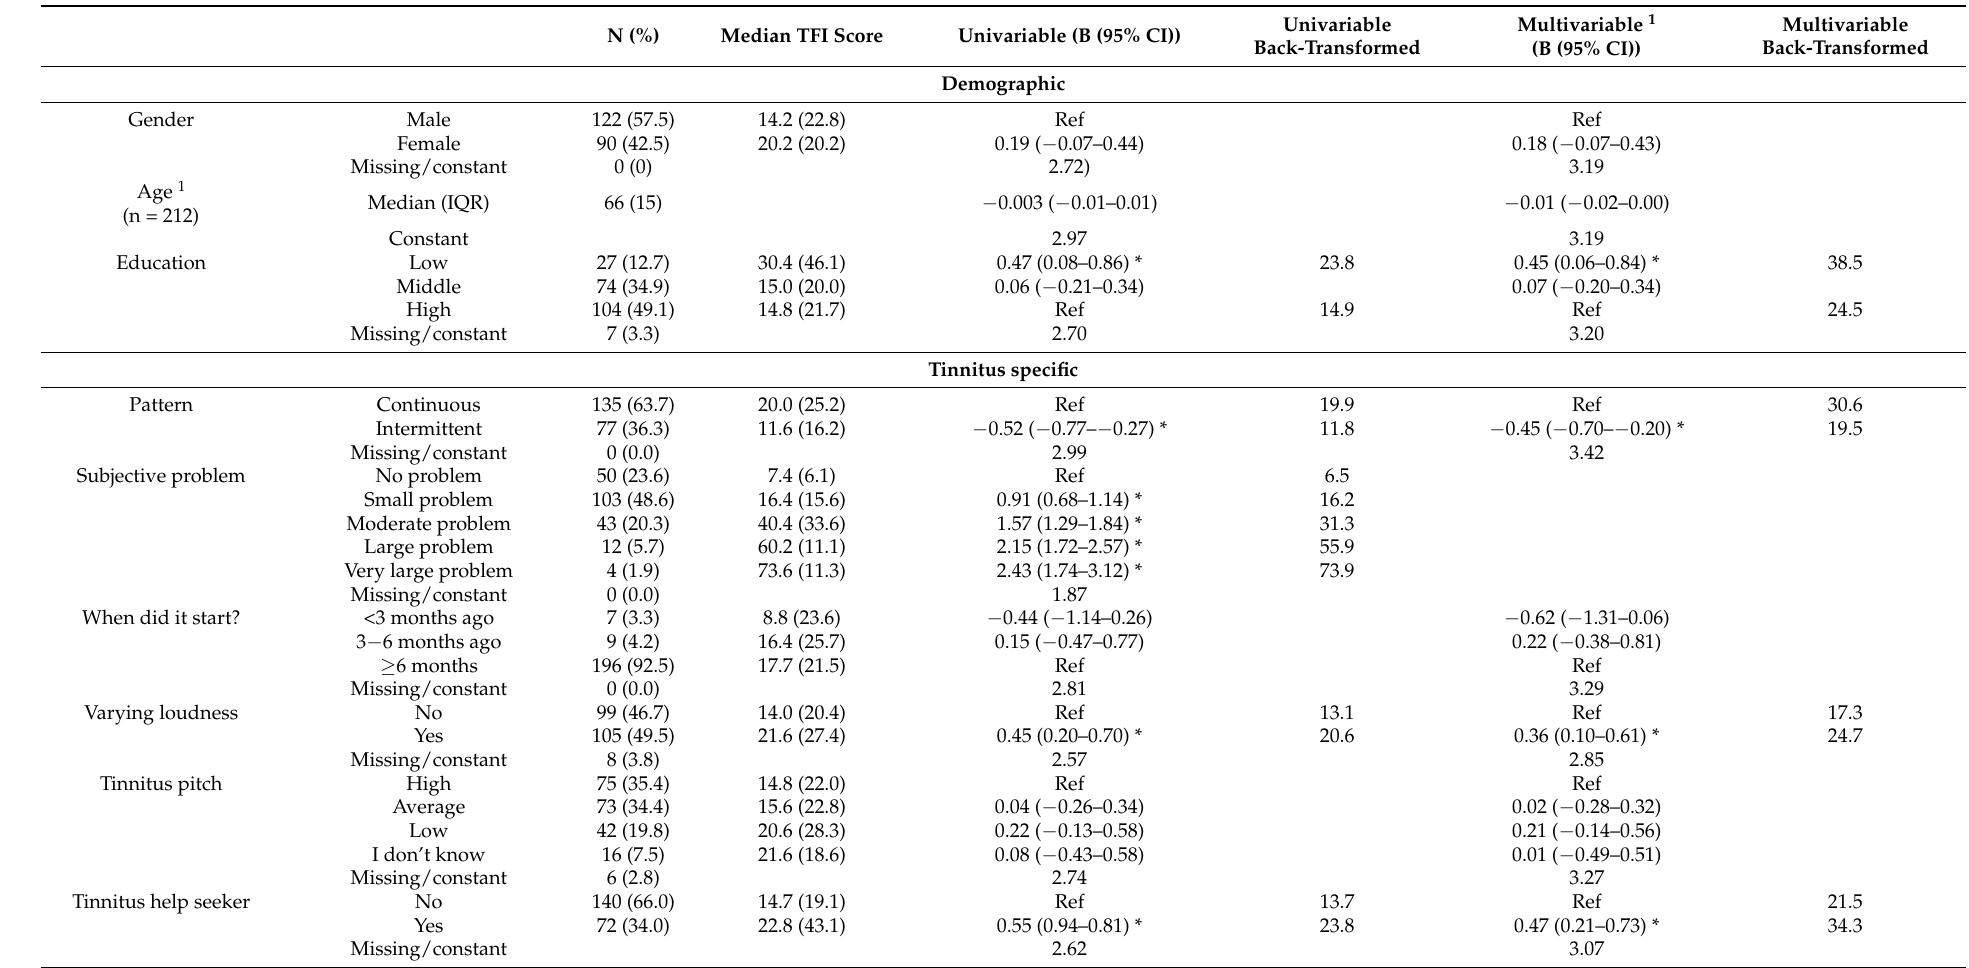
Table 1. Baseline characteristics, Univariable and Multivariable B-scores and back transformed TFI